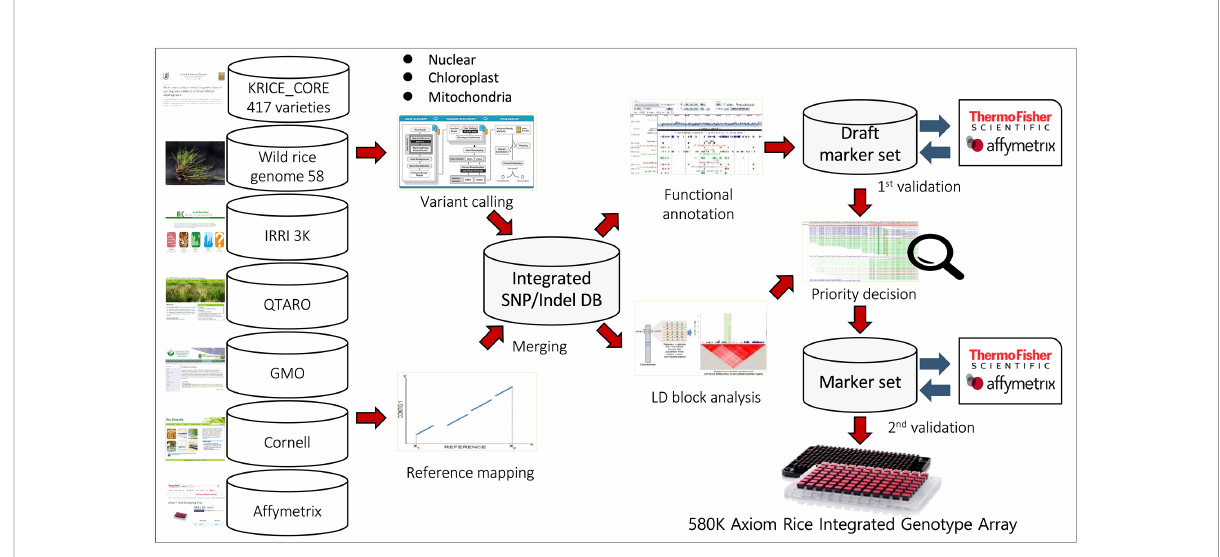
FIGURE 1 Schematic of 580K _ KNU chip design. SNPs were collected from eight different datasets, including 1) Resequencing data of 475 KRICE, 2) 3K-RGP from IRRI, 3) 700K rice array from Cornell University, 4) Affymetrix 44K Rice Chip, 5) QTARO database, 6) Plant Reactome Gramene database, 7) Chloroplast and mitochondria genomic sequence and 8) GMO